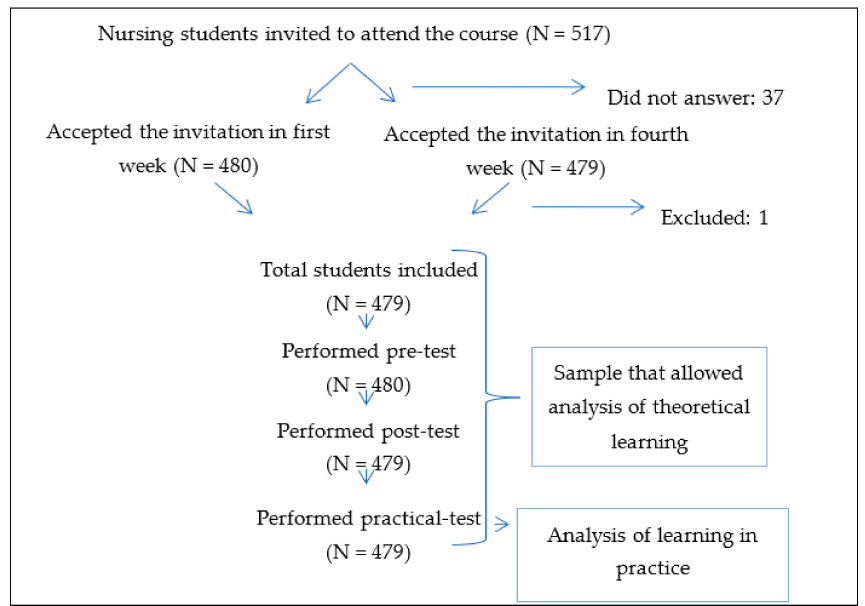
Figure 1. Flow diagram of the